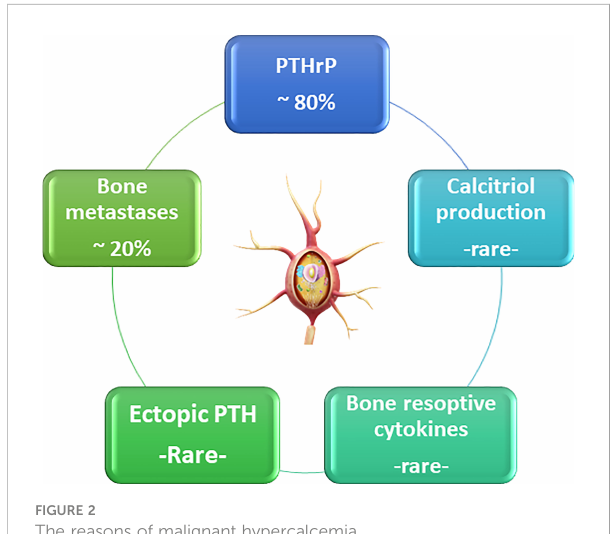
FIGURE 2 The reasons of malignant